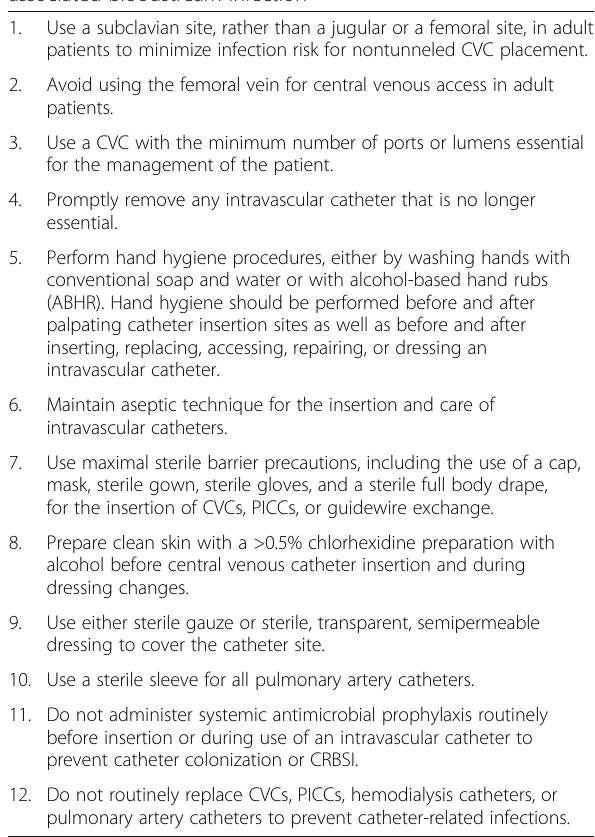
Table 1 Hospital guidelines for the prevention of catheter- associated bloodstream